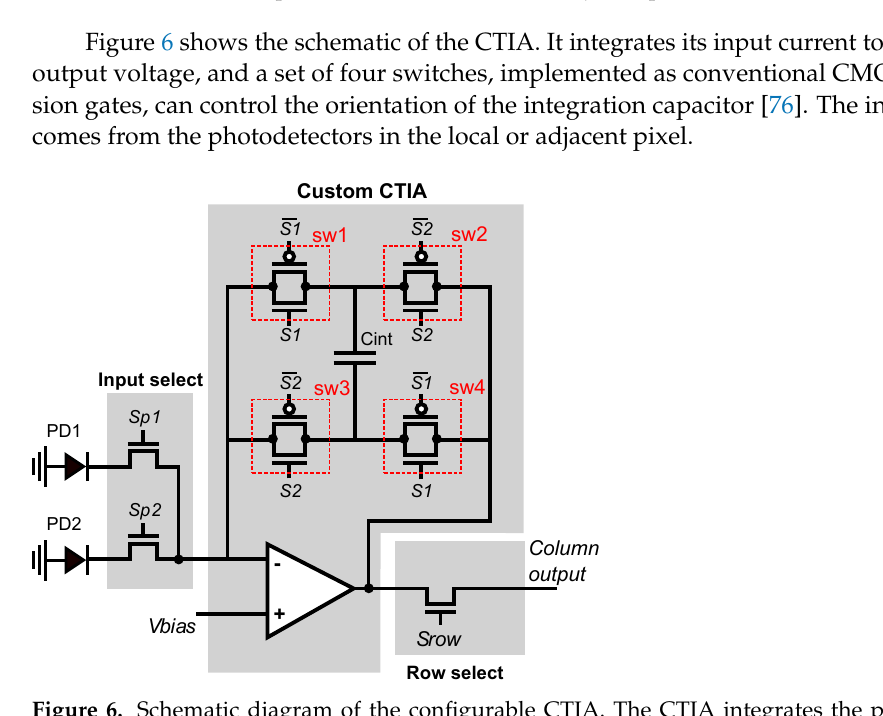
Figure 5. The smart pixel consists of an analog input-select multiplexer, a configurable CTIA, and a row-select switch. All the smart pixels in the array share the control signals placed above in the figure, and all the pixels in the same column share the column output signal. The input to the CTIA can be selected from the photodetector in the local or adjacent pixel.